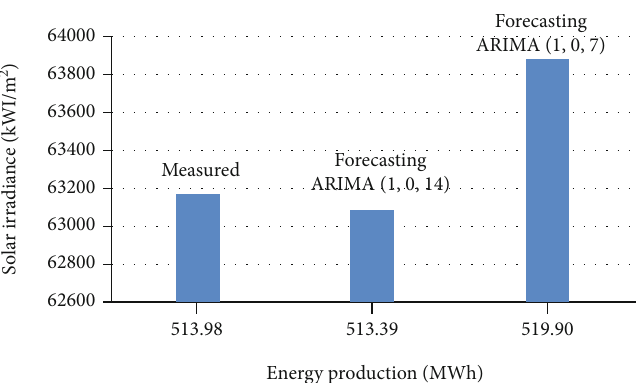
Figure 19: Di ff erence between the measured values of solar irradiance and predicted ones based on the ARIMA